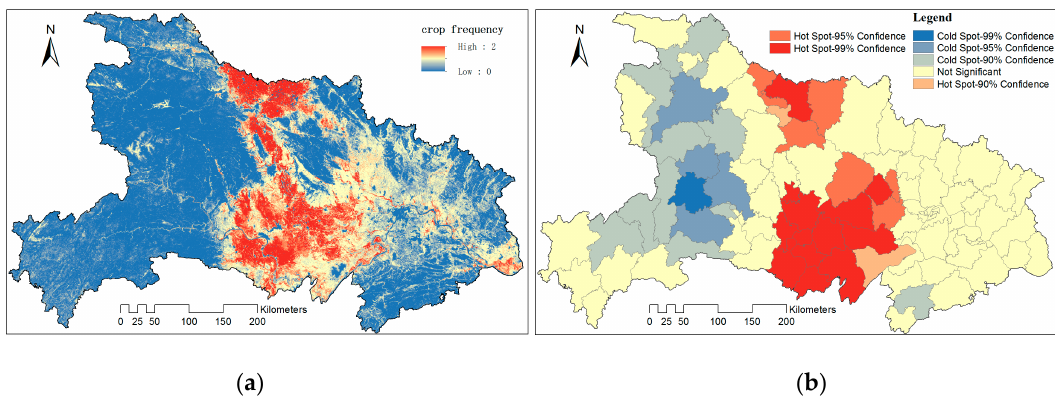
Figure 8. ( a ) The average cropping frequency of Hubei during 2001 and 2015; ( b ) Hot spot analysis of the average cropping frequency.